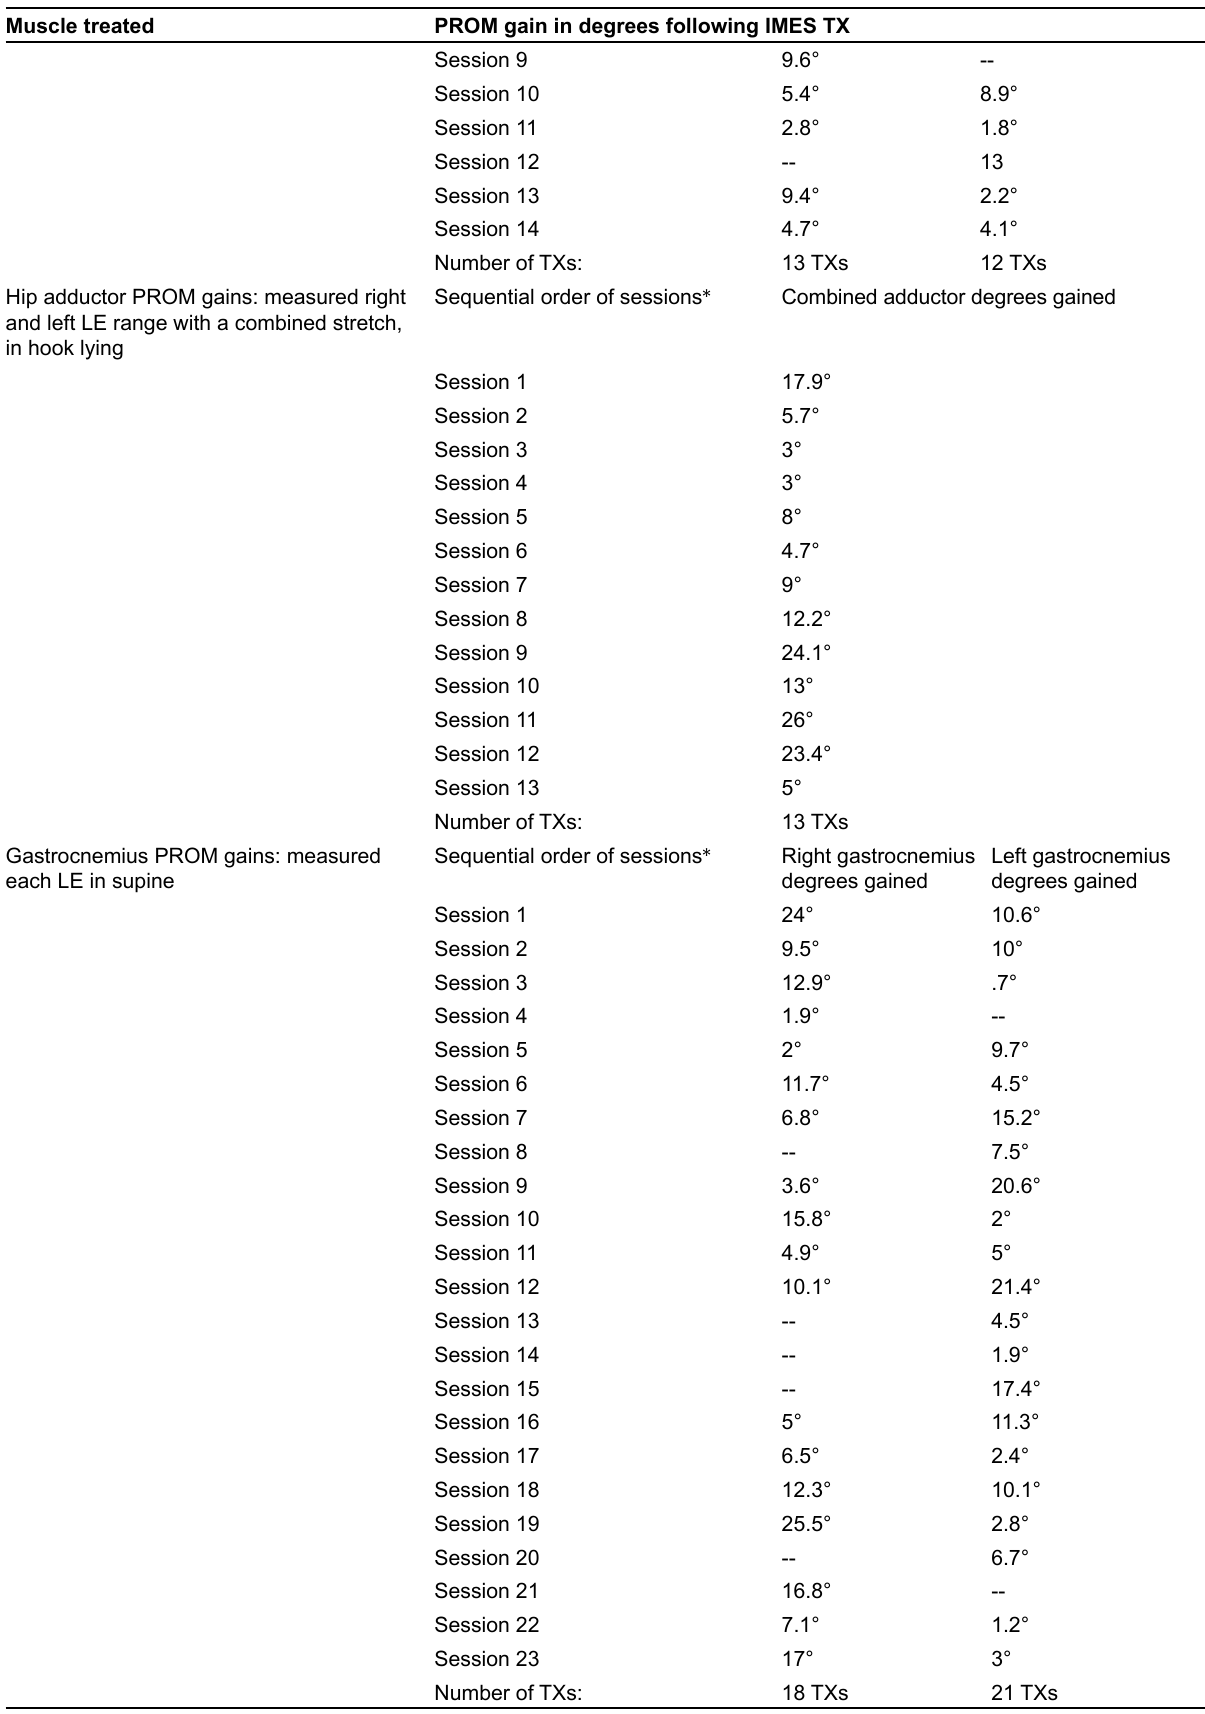
Table 2. Trend of PROM gain in degrees following IMES TX ( continued ) Muscle